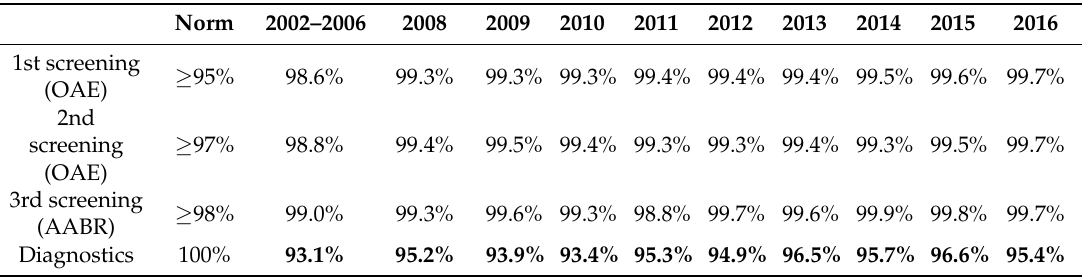
Table 1. Participation in screening and diagnostics 2002/2006–2016.